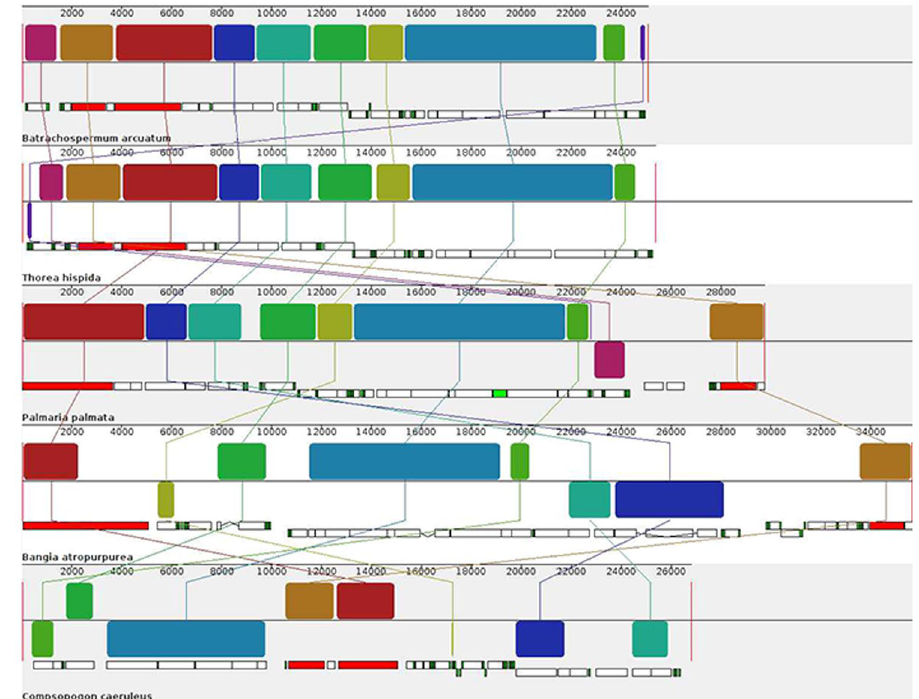
Figure 2. Synteny alignment of mitochondrial genomes between freshwater representatives. Each colored bar represents a locally collinear block and is assigned a unique color. White, red and green boxes represent annotated CDS (protein-coding sequence), rRNAs and tRNAs in the genomes respectively. Sequences each colored bar covered are homologous among the aligned genomes. The colored lines connect similar colored blocks and indicate which regions in each genome are